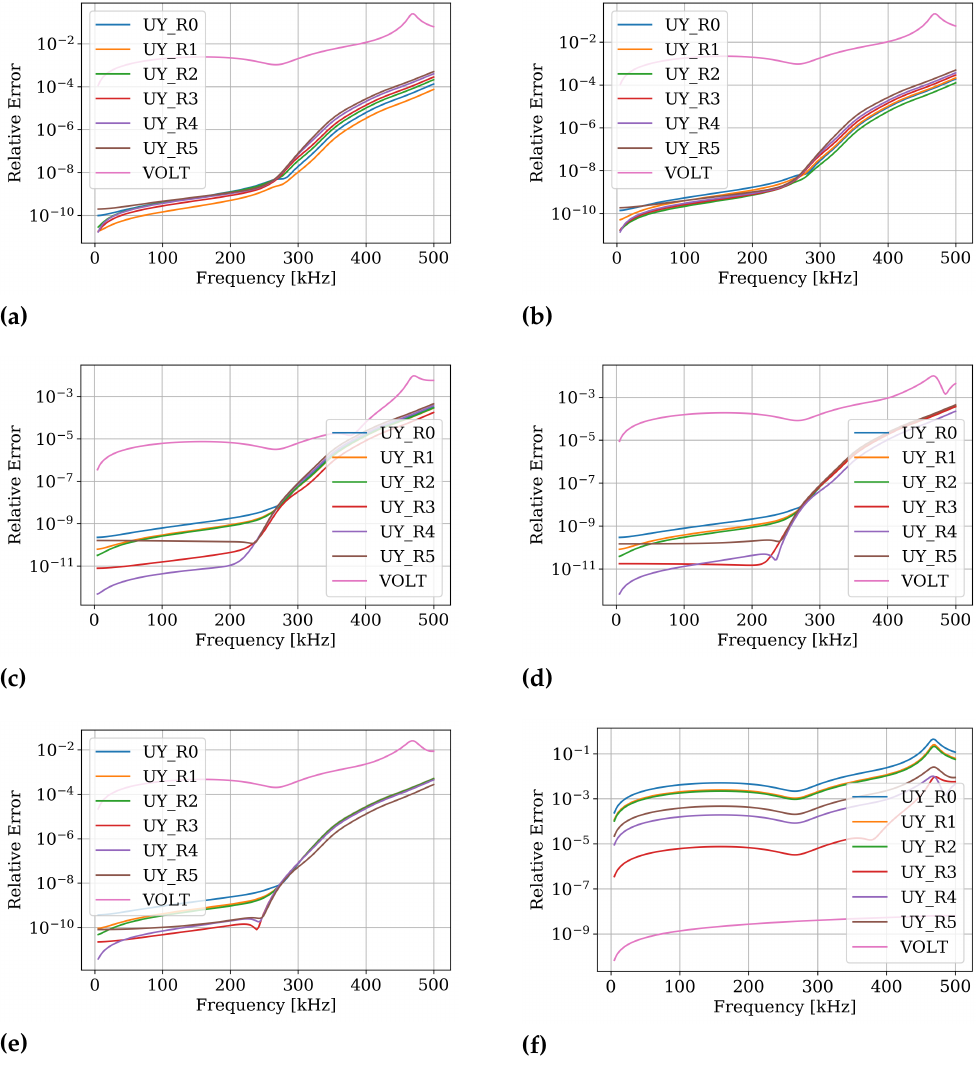
Figure A1. Harmonic relative error of each of the ROM’s outputs for a single input each. ( a ) Unit force at R 1 ( b ) Unit force at R 2 ( c ) Unit force at R 3 ( d ) Unit force at R 4 ( e ) Unit force at R 5 ( f ) Unit charge at the